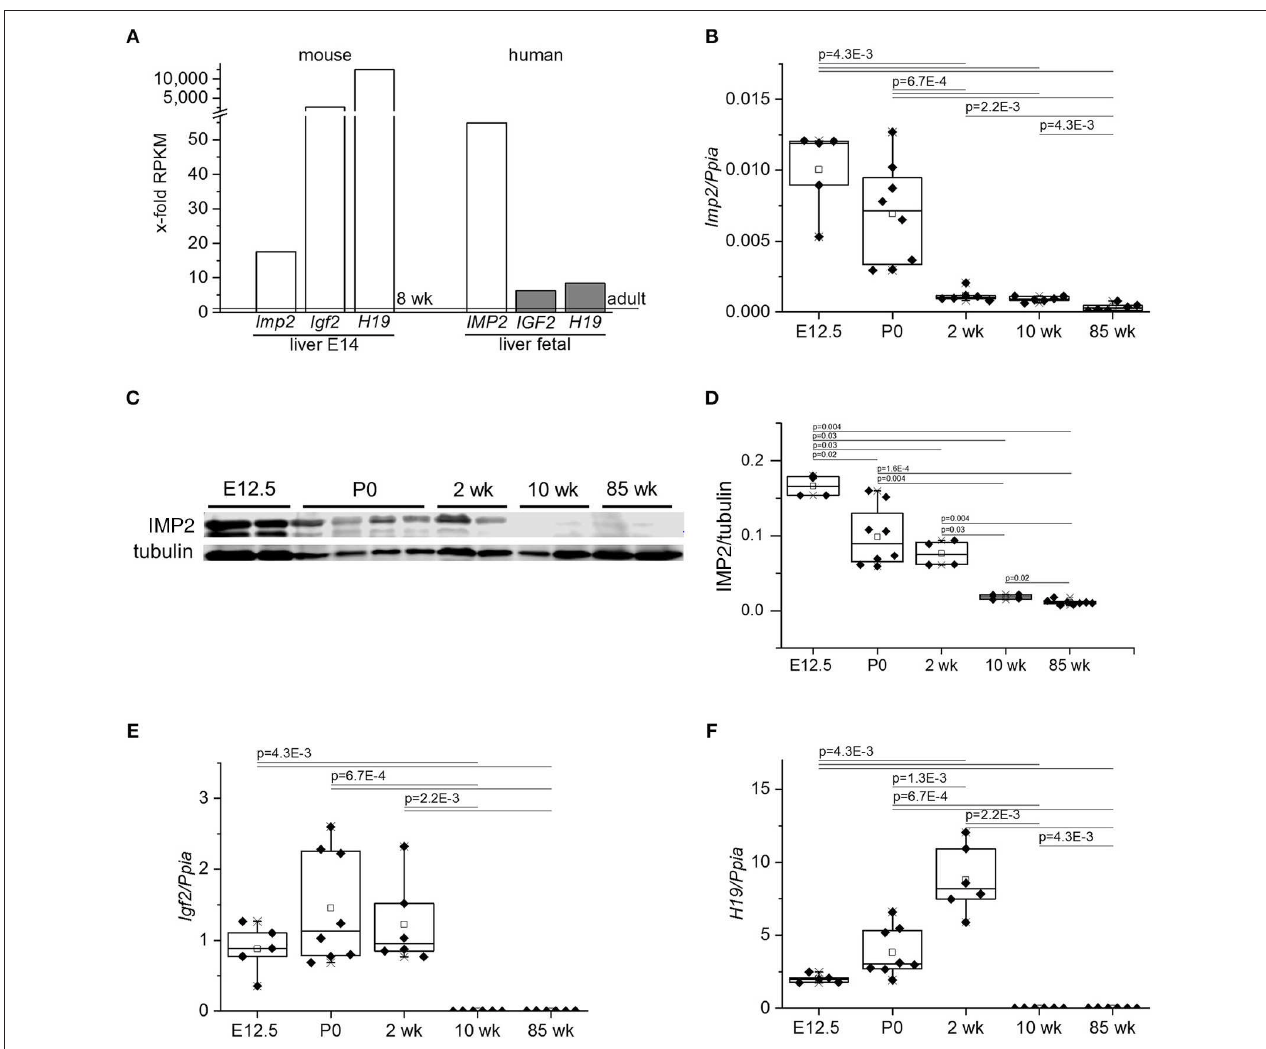
FIGURE 1 | Expression of IMP2 , IGF2, and H19 in embryonic and adult livers. (A) IMP2 , IGF2, and H19 gene expression from publicly available RNA sequencing data sets of murine (PRJNA66167) and human (PRJNA280600) fetal liver compared to adults. Data are expressed as x-fold from 8 week-old murine or adult human tissues indicated by dashed lines, respectively. RPKM: Reads per kilobase transcript per million reads. (B,E,F) qPCR analysis of Imp2 (B) , Igf2 (E) , and H19 (F) in livers of fetal (E12.5; n = 5), newborns (P0, n = 8), 2, 10, and 85 week-old (each n = 6) mice. Expression levels were normalized to Ppia / Cyclophilin as housekeeping gene. (C,D) Western blot analysis of IMP2 protein expression in fetal, newborn, young, and adult mouse livers. Representative image of Western blot (C) and densitometric quantification of IMP2 levels normalized to tubulin (D) are shown (E12.5: n = 4; P0: n = 8; 2 and 10 week: n = 4; 85 week: n = 6). P -values were calculated by Mann-Whitney U